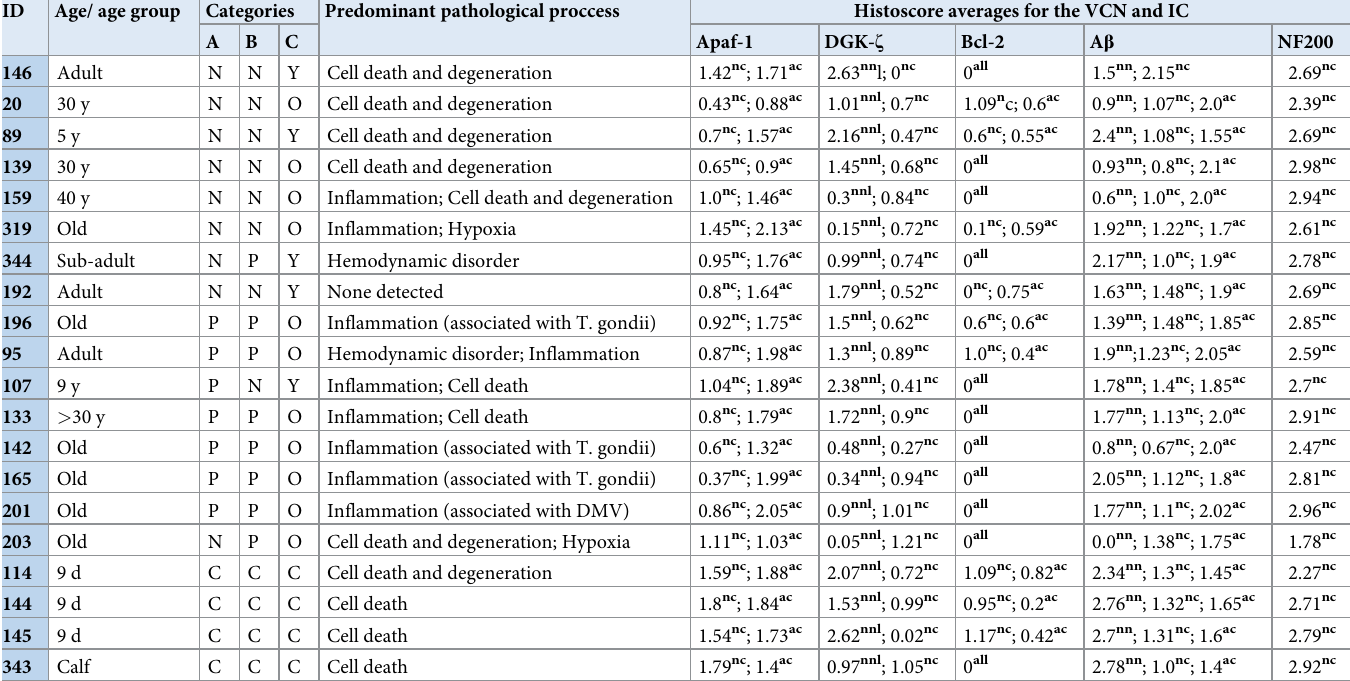
Table 1. Summary of the ID, age group, predominant pathological process detected histologically the CNS, and pooled histoscore averages of the protein marker immunoreactivity for the VCN and IC of the dolphins of this study (0—No immunoreactivity; 3—Very intense immunoreactivity).